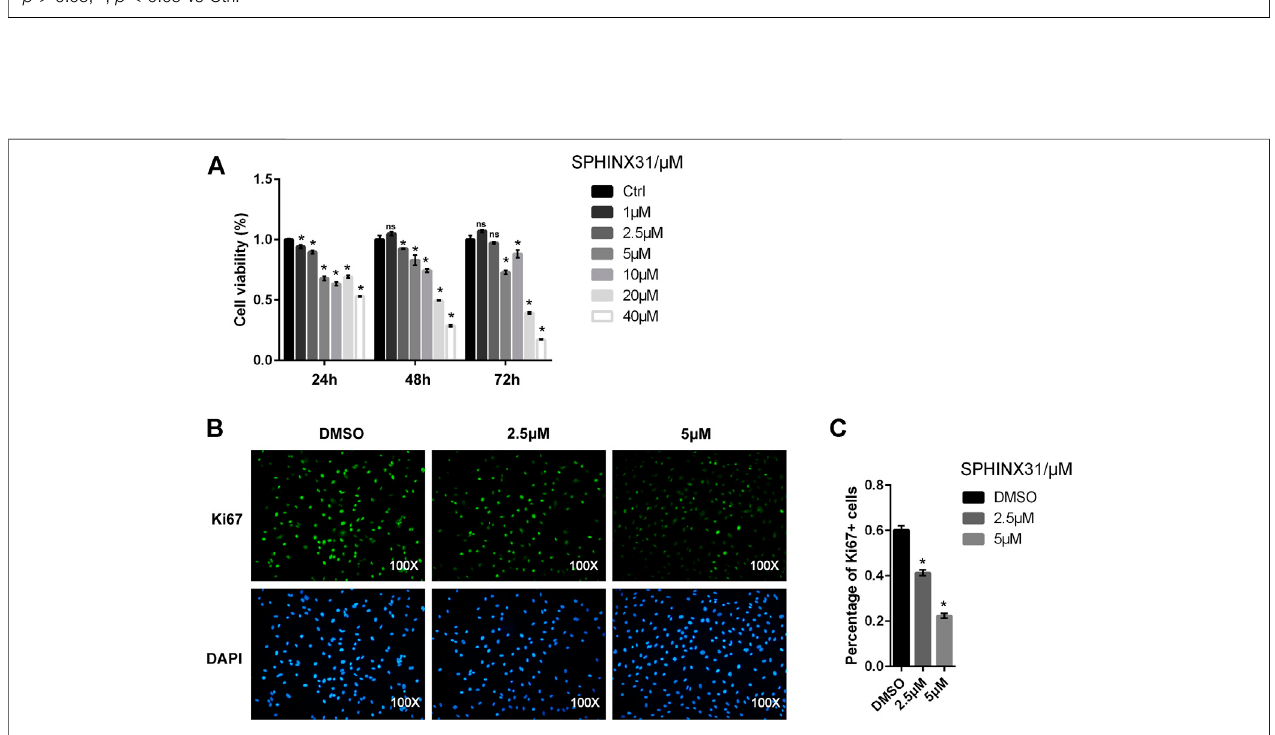
FIGURE2| EffectsoftheinhibitorofSRPK1oncellviabilityinHUVECs.HUVECsweretreatedwithdifferentconcentrationsofSPHINX31fortheindicatedtimewith cell viability measured via CCK-8 (A) . After treatment with different concentrations (2.5 and 5 μ M) of SPHINX31 for 24 h, the immuno fl uorescence staining for Ki-67 (green)andDAPI(blue)wasdetermined (B) .Imageswereobservedusing100× fl uorescencemicroscopywiththequanti fi cationsofPercentageofKi-67+cells (C) .The data are presented as the mean ± SD of three independent experiments. Two-way ANOVA with Bonferroni test (A) and one-way ANOVA with a least signi fi cant difference post hoc test (C) were used. ns, p > 0.05; *, p < 0.05 vs Ctrl.